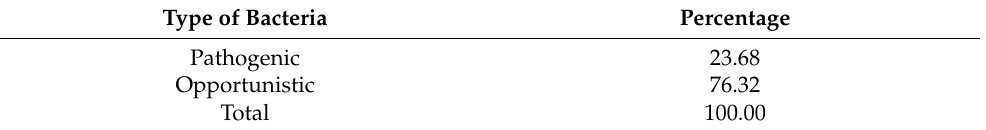
Table 5. Culture results.